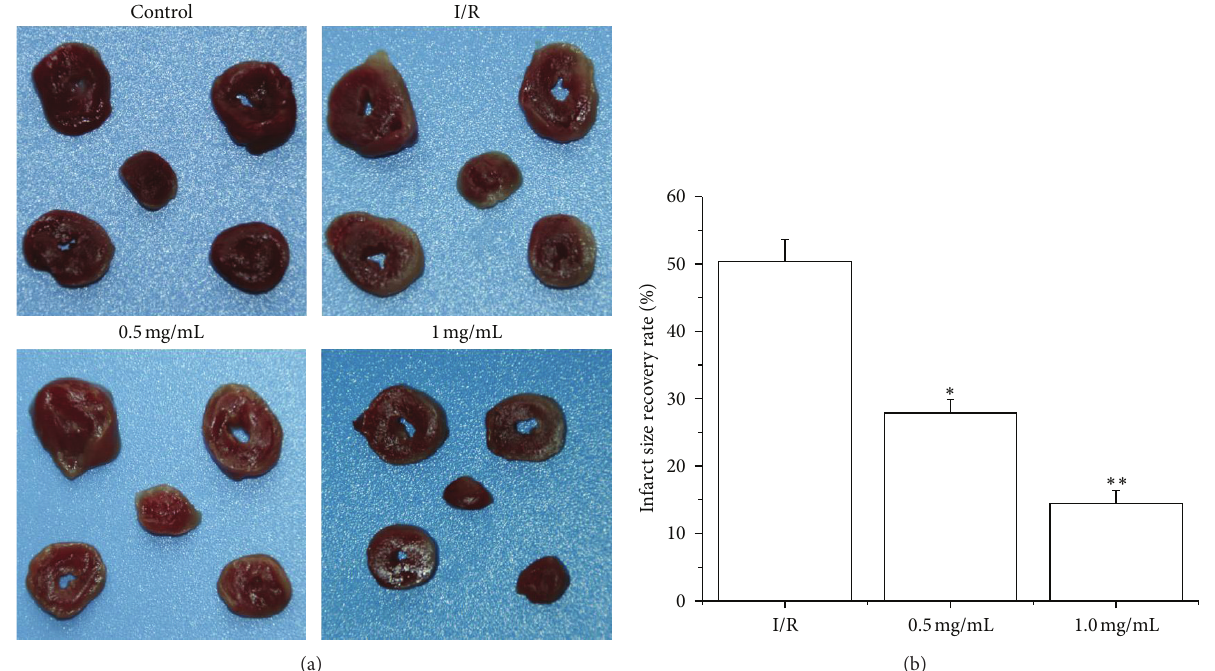
Figure 2: Effects of the aqueous extract of Elaeagnus angustifolia L. leaves upon myocardial infarct size. Data are the mean ± SD. Values marked with ∗∗ 𝑃 < 0.01 and ∗ 𝑃 < 0.05 are significantly different from I/R